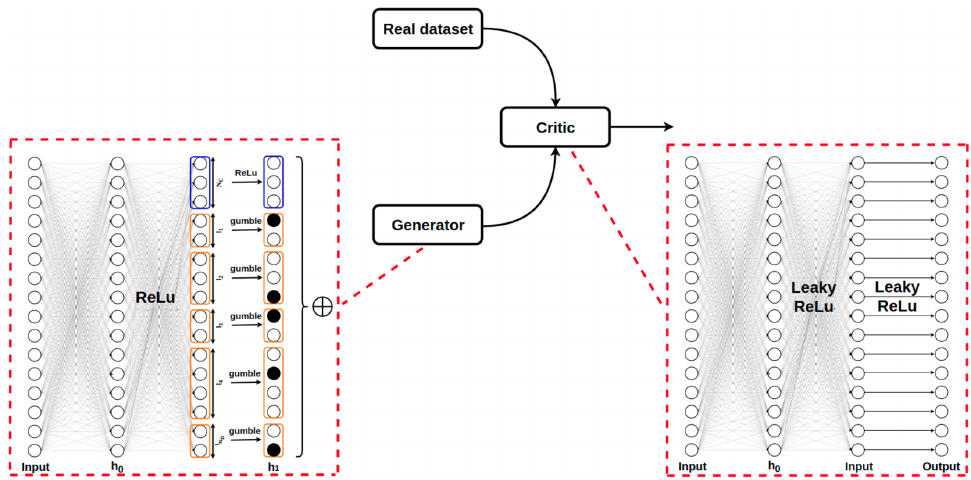
Figure 19. TabFairGAN architecture. Image taken from